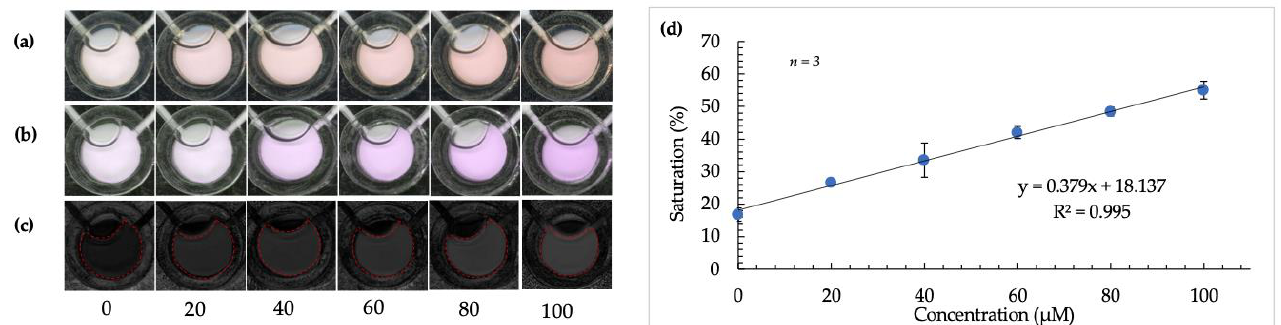
Figure 6. Calibration curve using optimized microdevice and image-analysis techniques. ( a – c ) show images of detection windows with increasing color intensity as arginine concentration increases (from left to right) before image tinting, following image tinting, and after RGB to HSB color-space conversion, respectively. ( d ) is a plot showing the robust and linear correlation between saturation value and increasing concentration of arginine in fingermark deposits using a microdevice.